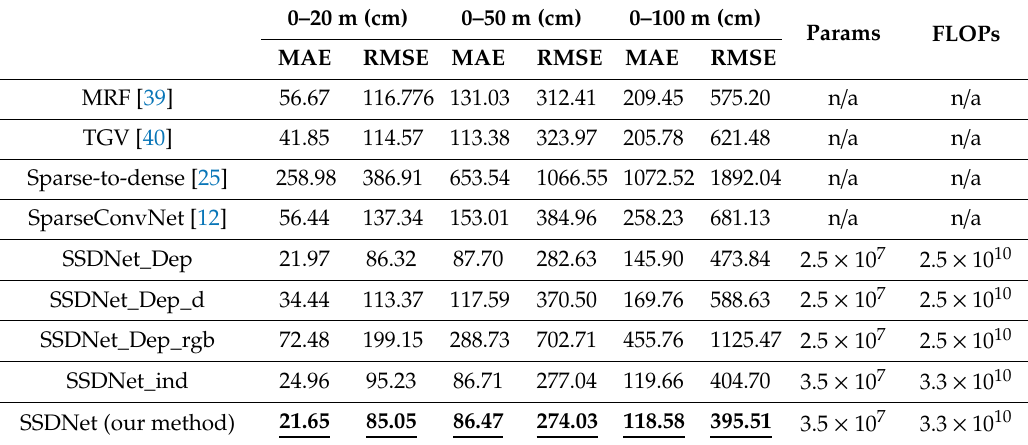
Table 3. Depth Completion Ablation Experiment on Virtual KITTI Dataset.